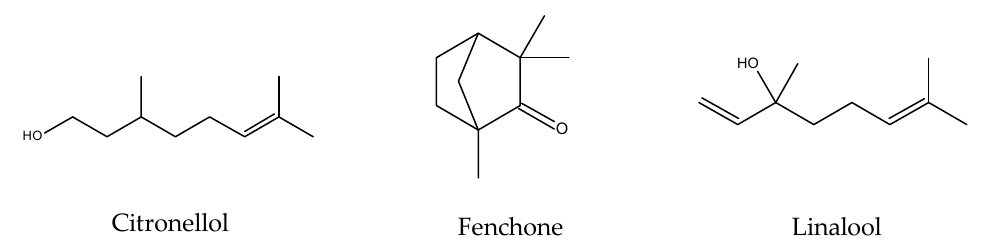
Figure 3. Chemical structures of citronellol, fenchone and linalool.